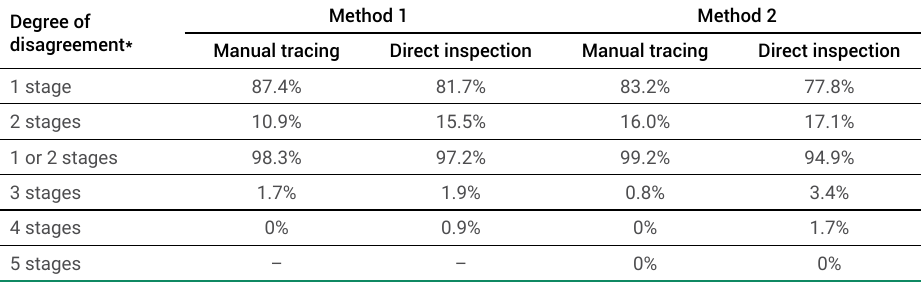
Table 3. Distribution of intraexaminers degree of disagreement in accordance to the amount of CVM stages in disagreement between T1 and T2 moments. Degree of disagreement*